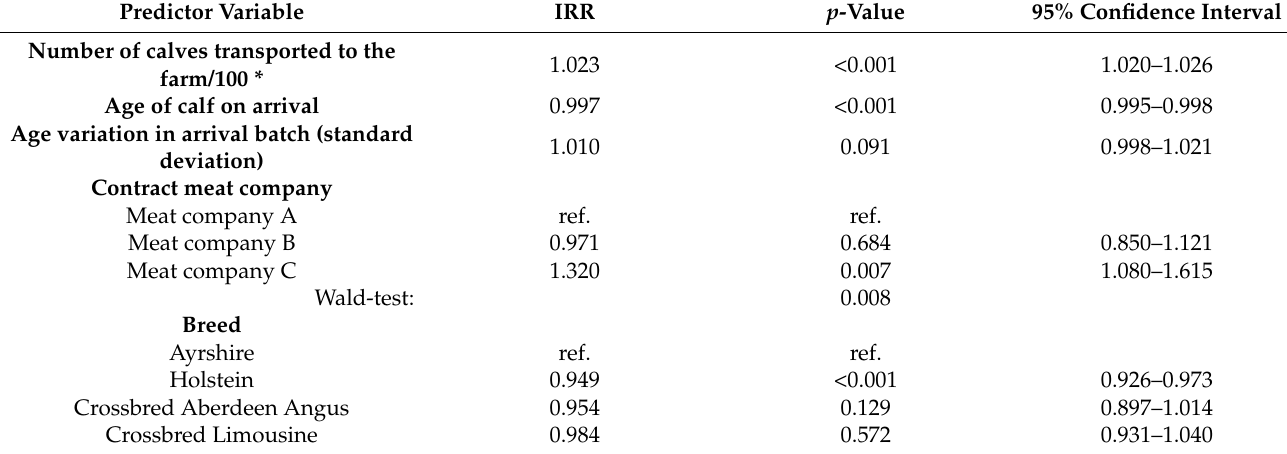
Table 8. Multivariate mixed Poisson regression model to study the association between a calf’s incidence rate ratio (IRR) of being recurrently medicated during the 180-day follow-up and predictor variables in 87 herds. The average follow-up time for 28,228 study calves was 150.8 days when early transportations to the finishing units and untimely deaths were taken into